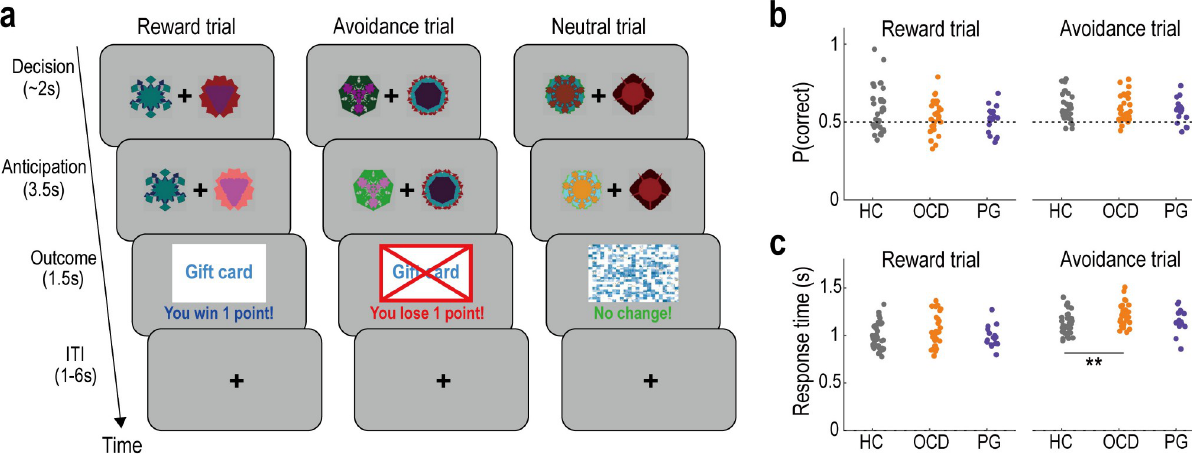
Fig 1. Experimental task and basic behaviour. (a) Illustration of the probabilistic instrumental learning task. In each reward trial, the participants select one of the two options (the fractal images) and either receive a reward (“You win 1 point!”) or nothing, depending on the probability assigned to the chosen option. In each avoidance trial, participants receive either a loss (“You lose 1 point!”) or nothing. In each neutral trial, a visual image not associated with monetary incentives is presented with the message (“No change!”). ITI, intertrial interval. (b) The proportion of correct choices in reward and avoidance trials. Here, the correct choice is defined as selecting the option that provides a higher reward (or lower loss) probability in the given trial. HC, healthy control; OCD, obsessive-compulsive disorder; PG, pathological gambling. (c) Mean response time (seconds) in the reward and avoidance trials. �� P < 0.01, two-tailed Welch’s t test, Bonferroni-corrected for the two tests performed: HC vs. OCD, and HC vs. PG. Summary data to reproduce the figure are available at https://osf.io/v7em5/.